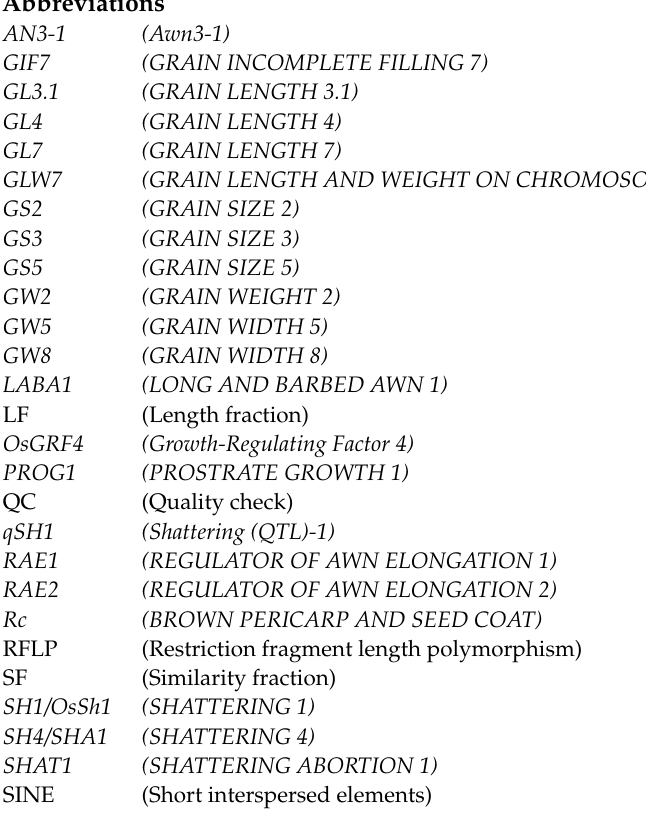
Table S5: List of non-synonymous amino acid changes in RAE1 gene; Table S6: Summary of 26 wild rice samples collected from 26 different geographical locations in northern Queensland, Australia; Table S7: List of non-synonymous amino acid changes in RAE1 gene; Table S8: Total number of single nucleotide polymorphisms (SNPs) and corresponding amino acid changes (AAC) of three grain size loci in 26 Australian wild rice samples: (A) GS2 ( GRAIN SIZE 2 ), (B) GS5 ( GRAIN SIZE 5 ), (C) GW8 ( GRAIN WIDTH 8 ); Table S9: Summary of 26 wild rice samples collected from 26 different geographical locations in northern Queensland, Australia; Table S10: Sequences of domestication genes